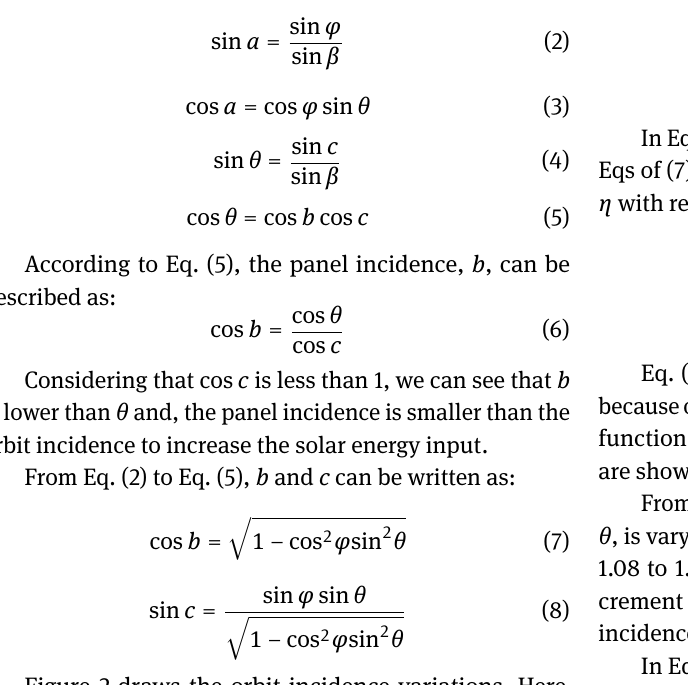
Figure 2 draws the orbit incidence variations. Here, with consideration of secular orbit drifts, the varying panel